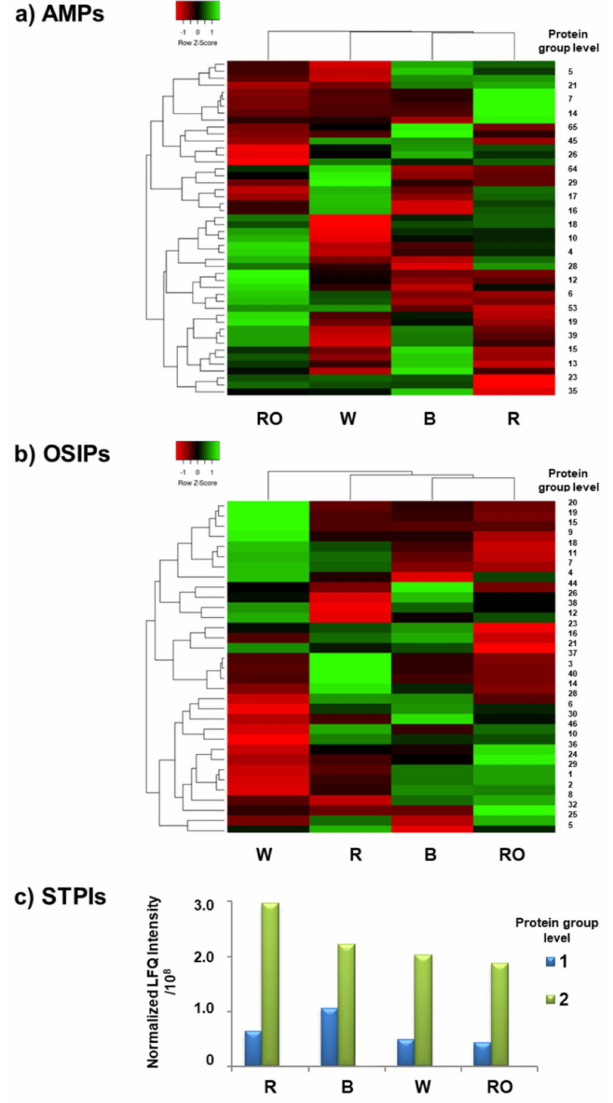
Figure 3. Heat maps obtained using the row z-score normalized LFQ intensities of the identified ( a ) AMPs and ( b ) OSIPs in the four analyzed commercial quinoa grains, R, B, W, and RO; ( c ) bar graph obtained using the average normalized LFQ intensities of the identified STPIs in the four quinoa grains. Only AMPs, OSIPs, and STIPs identified in the four quinoa classes were